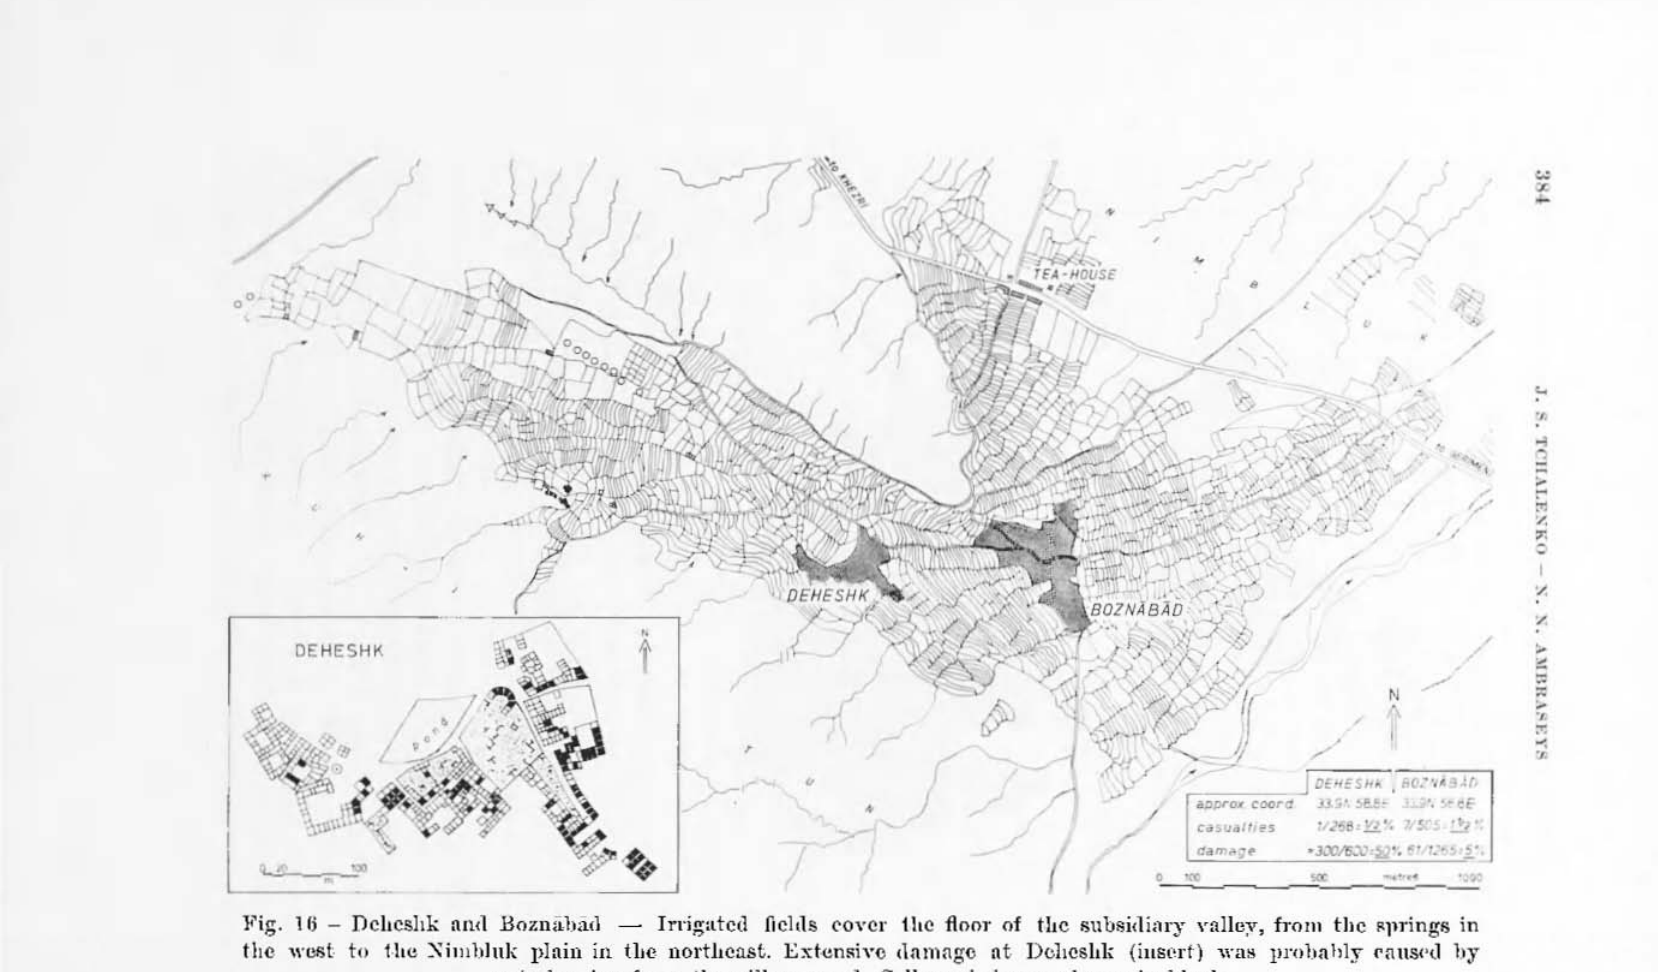
Fig. 16 - Dcllcshk :lnd BOZll:Lbad